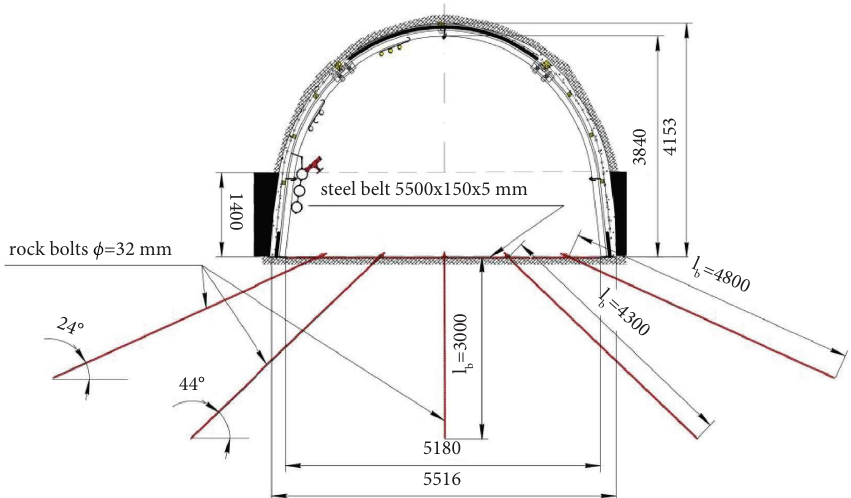
Figure 23: Design of support